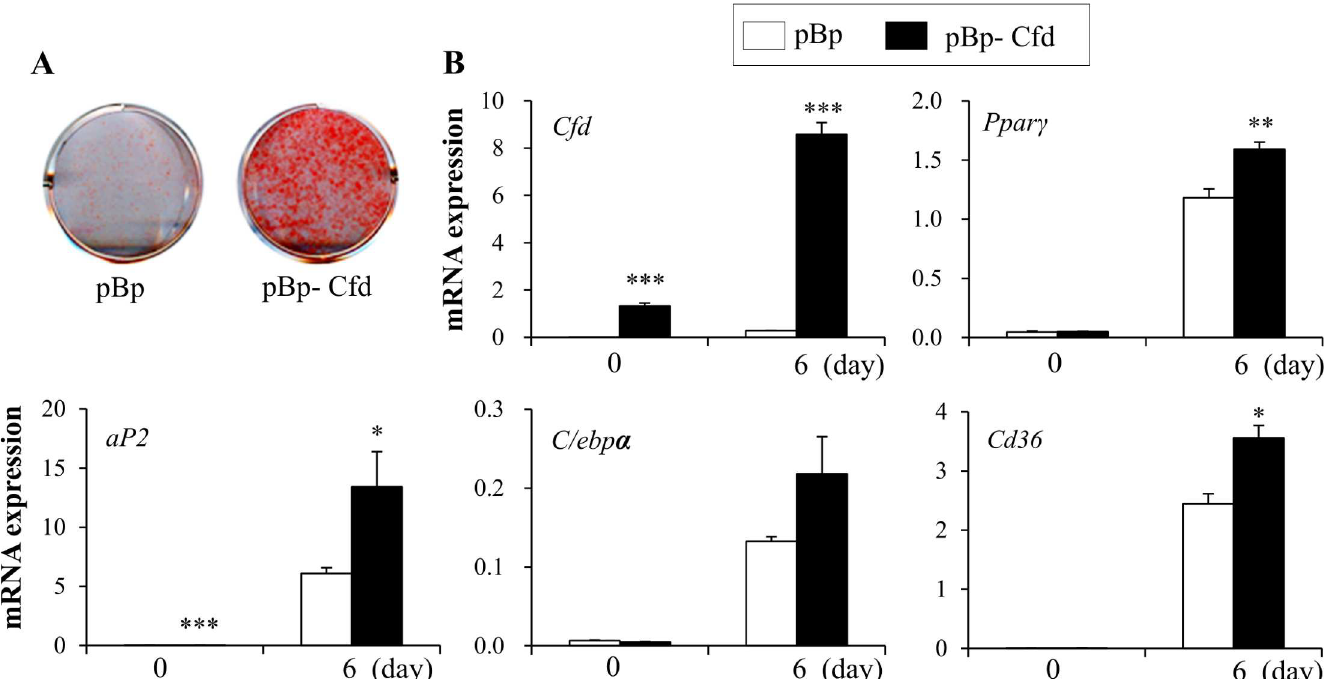
Fig 4. Stable overexpression of Cfd promoteslipidaccumulationand adipocytedifferentiation. 3T3-L1cells were infected with pBabe-puro empty vector (pBp)or pBabe-Cfdgene harboringretrovirus(pBp-Cfd)and stable pools selectedusing puromycin(2 ug/ml)for 2 weeks. The stable 3T3-L1 preadipocytes were induced into adipocytesin adipogenic mediumcontaining DMEM,10% FBS, dexamethasone, IBMX, insulin,and the selected compounds. Then,the 3T3-L1cells were refreshedwith mediasupplemented with insulin and compounds every 2 days. ( A ) Stable cells were differentiated into adipocytes for 6 days and lipid accumulationwas assessed by Oil red O staining.( B ) Expression of Cfd and adipocyte markerswas measuredon day 0 and day 6 of differentiation by real timePCR analysis. Data are presentedas means +/- s.e.m. and are representative of three independent experiments. Each independent experiment was carriedout in triplicate.Statisticalsignificance was determinedrelative to a controlby the Student’s t -test( * P < 0.05; ** P < 0.005; *** P < 0.0005).